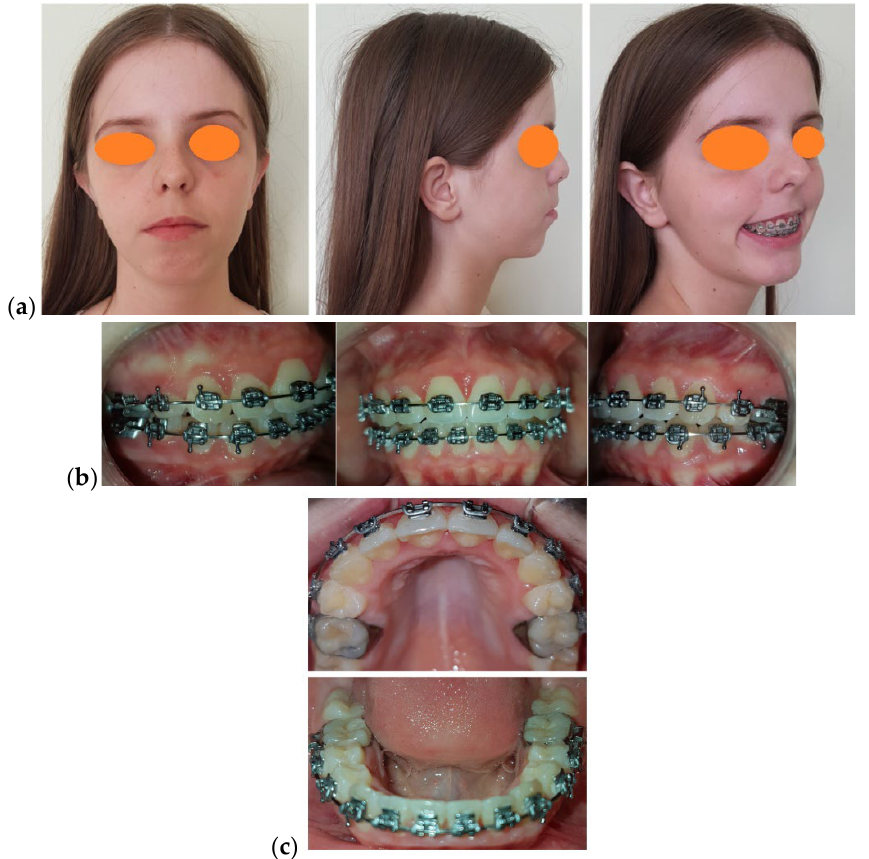
Figure 3. Pre-surgical photographic examination: ( a ) Facial aspect: frontal view, profile, ¾ profile on smiling; ( b ) Intra-oral aspect: lateral right, frontal, and lateral left; ( c ) Intra-oral aspect: occlusal view.